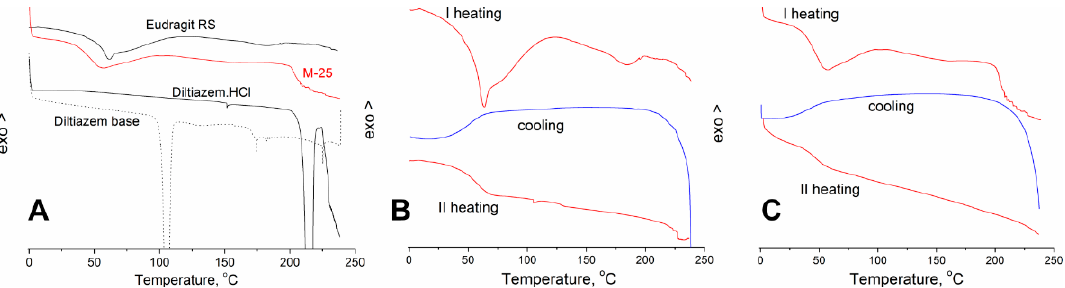
Figure 9. ( A ) Thermograms of diltiazem base, diltiazem hydrochloride, Eudragit RS 100, and M-25 sample in heating-only mode; ( B ) thermogram in the heating–cooling–heating mode of Eudragit RS 100; ( C ) thermogram in the heating–cooling–heating mode of M-25 sample.